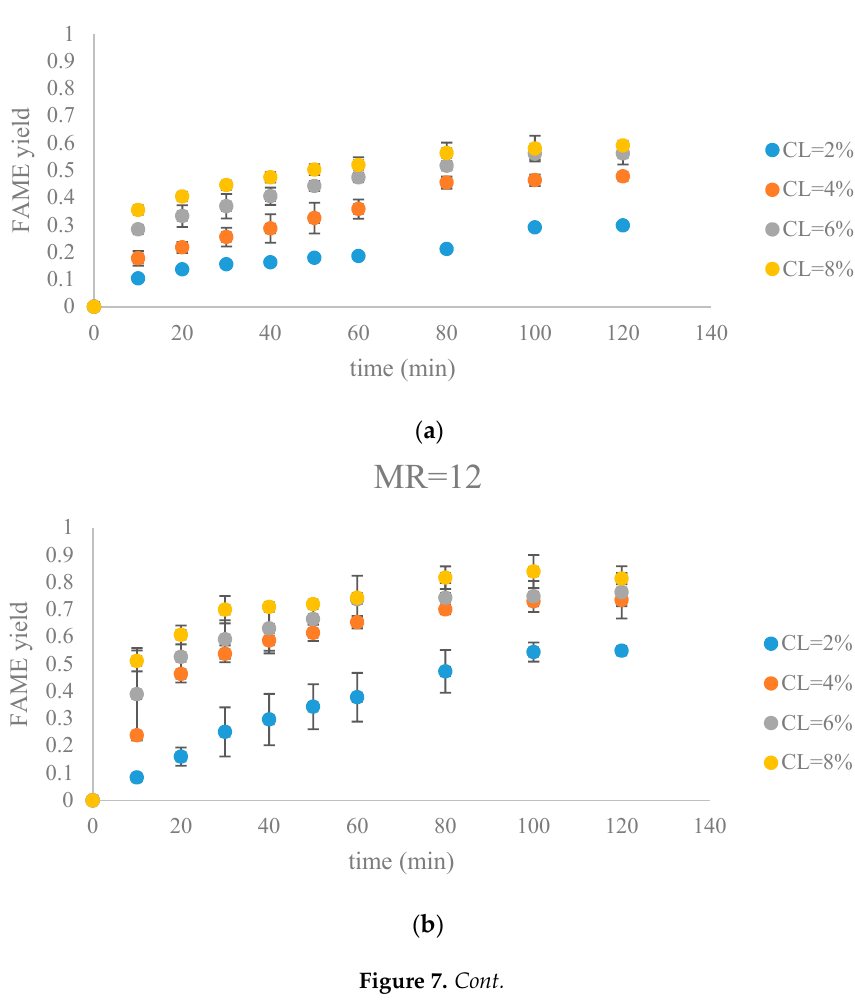
( c ) Figure 7. The fatty acid methyl ester (FAME) yield with the progress of the soybean oil transesterification catalyzed by Na-COS grouped by molar ratio of methanol to oil (MR) ( a ) MR = 6; ( b ) MR = 12; ( c ) MR = 18. ( a )